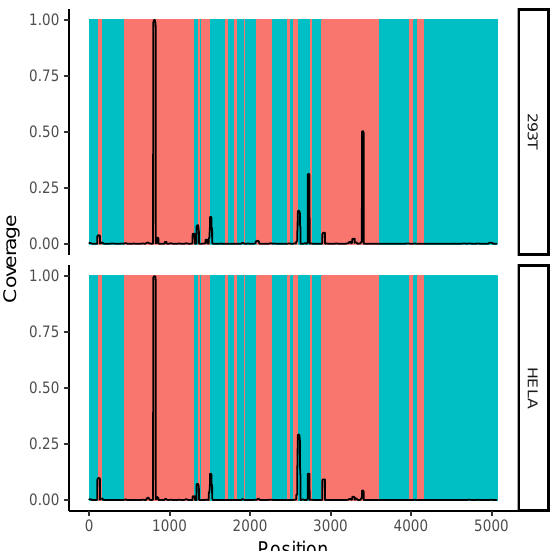
Figure 4. Read coverage with respect to 28S ribosomal RNA. Regions with orange background correspond to ribosomal expansion regions. One can see that regions with high read coverage are located within or adjacent to expansion regions. The shown data correspond to gel extraction of 293T cells or Hela cells (datasets S14 and S15 as listed in Table S1, Supplementary Materials). The coverage values were normalized such that, for each dataset, their highest coverage value on the 28S ribosomal RNA (rRNA) sequence was 1.0.